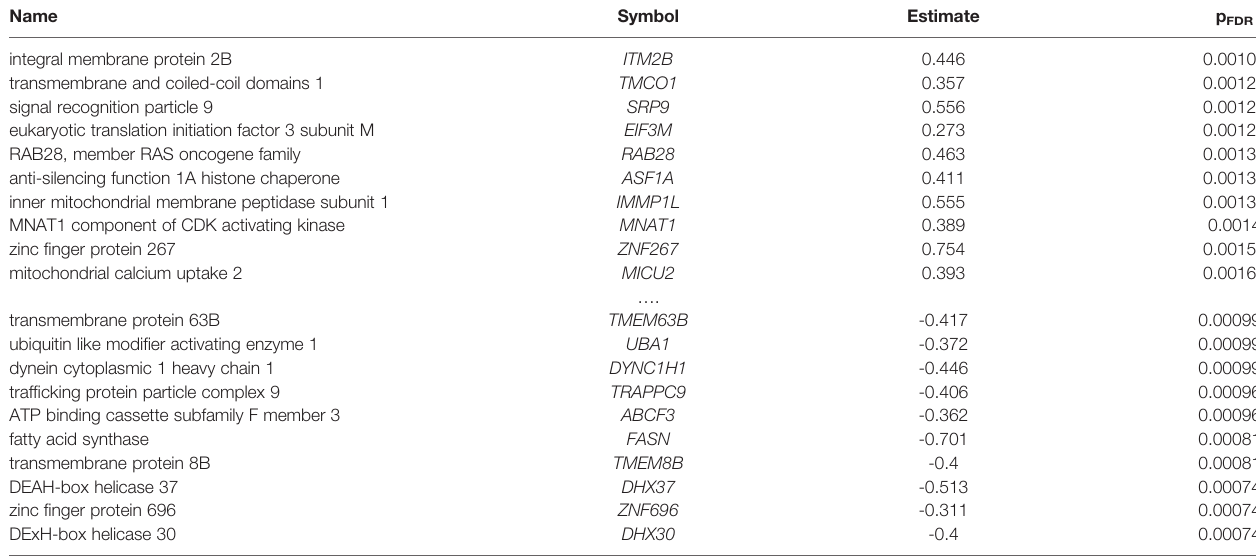
TABLE 2 | Top ten most up- and down-regulated differentially expressed genes in the prefrontal cortex with detected P. gingivalis reads. Name Symbol Estimate p